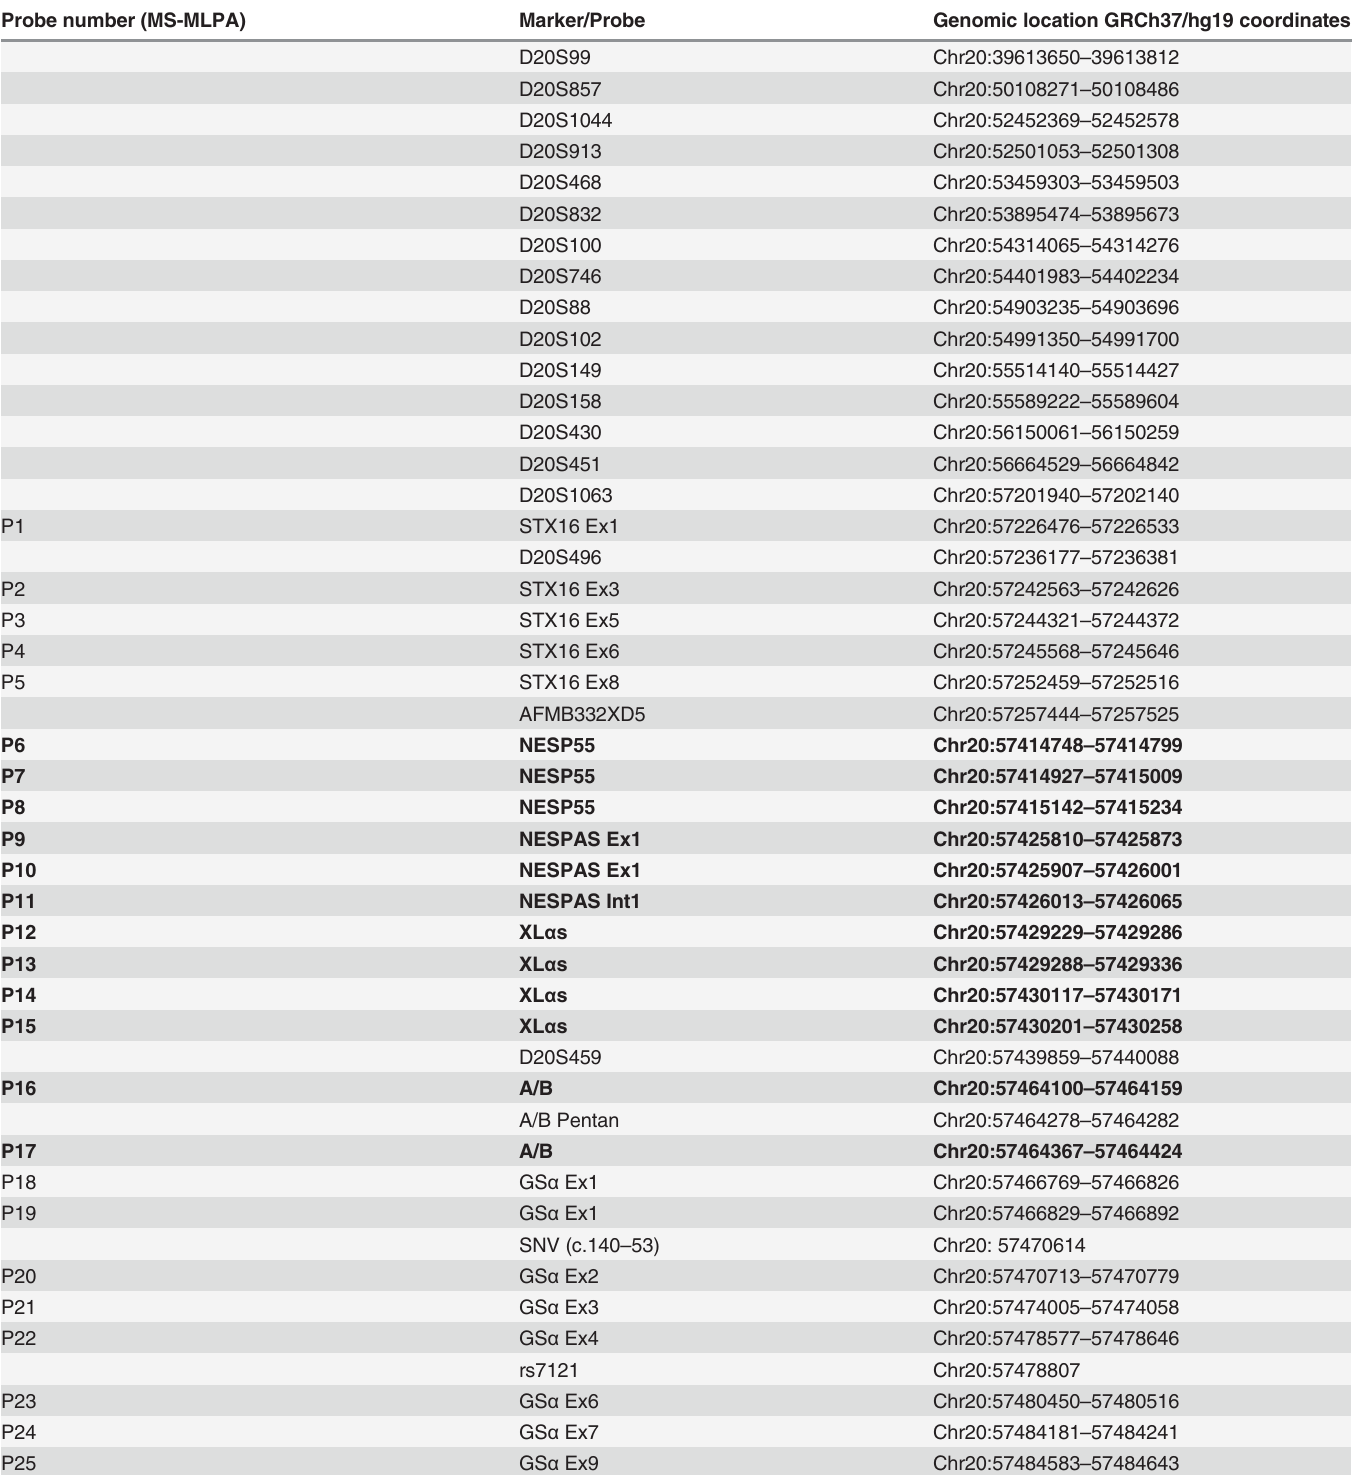
Table 1. Genomic location of the probes used for the MS-MLPA analysis and the 27 polymorphic markers in chromosome 20q mentioned in the